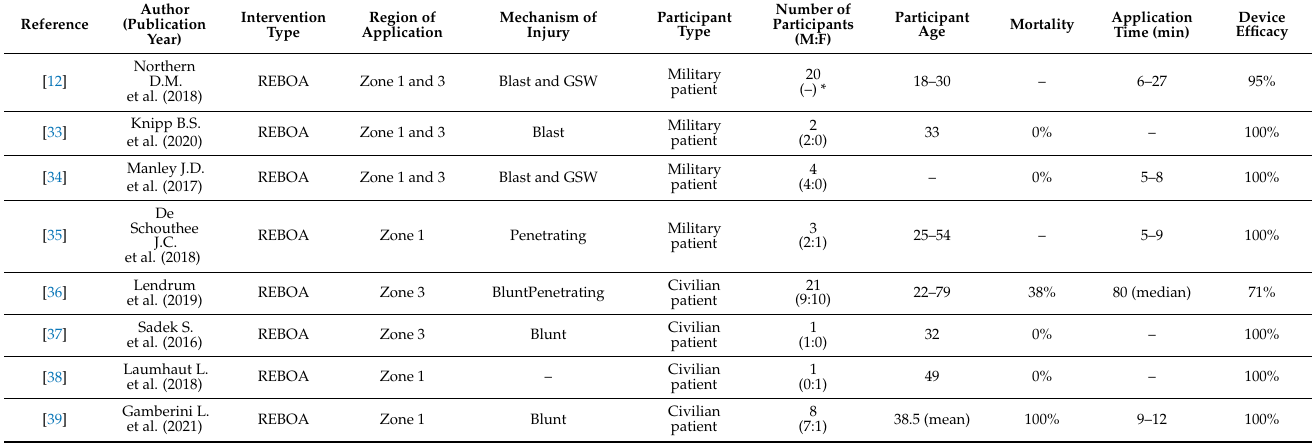
Table 6. Summary of REBOA study characteristics, patient demographics, and outcome measure